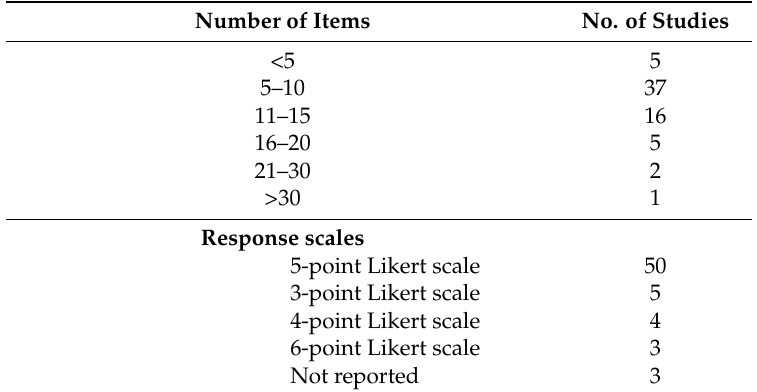
Table 3. Number of items and response scales in the 65 studies with self-developed